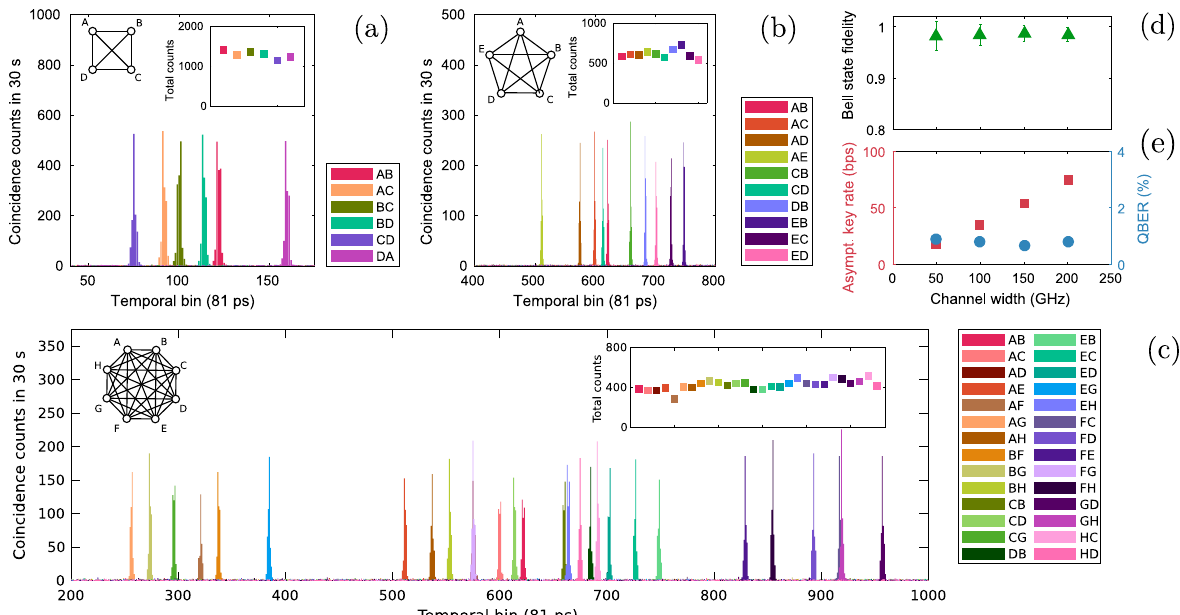
Fig. 5 Recon fi gurable multi-user entanglement network. a – c Time-correlation histograms for all two-user links in a fully connected network of size ( a ) N = 4 with 200 GHz channels, ( b ) N = 5 with 100 GHz channels, and ( c ) N = 8 with 50 GHz channels. Arti fi cial time delays were added in the different frequency channels to facilitate the visualization of all histograms in the same fi gure. d Lower bound to the fi delity to a Ψ þ j i Bell state and ( e ) Measured asymptotic key rate and QBER for ITU channels 23 (1558.98 nm) and 29 (1554.13 nm), as a function of channel